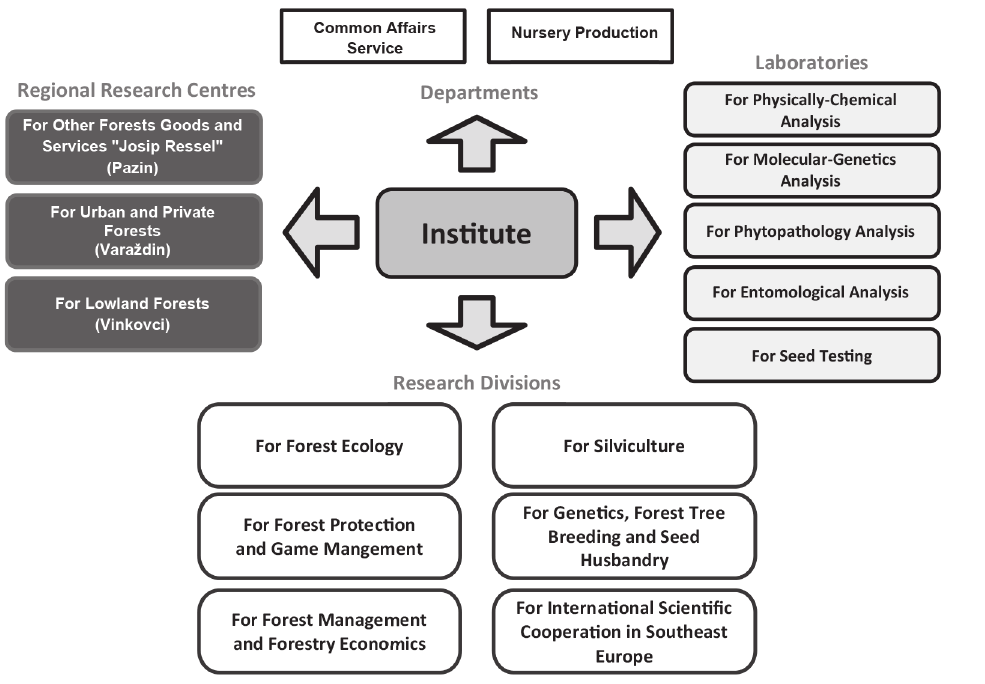
FIGURE 1. Organization of the Croatian Forest Research